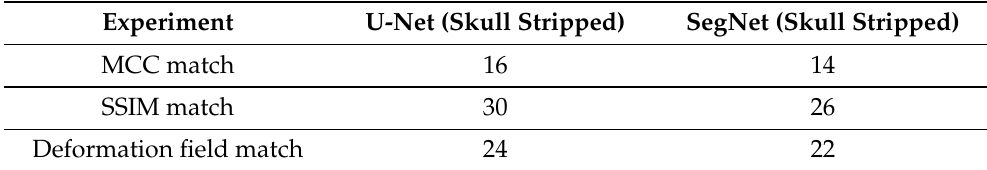
Table 3. Number of correct matches of reconstructed images to the corresponding true original images for n = 40